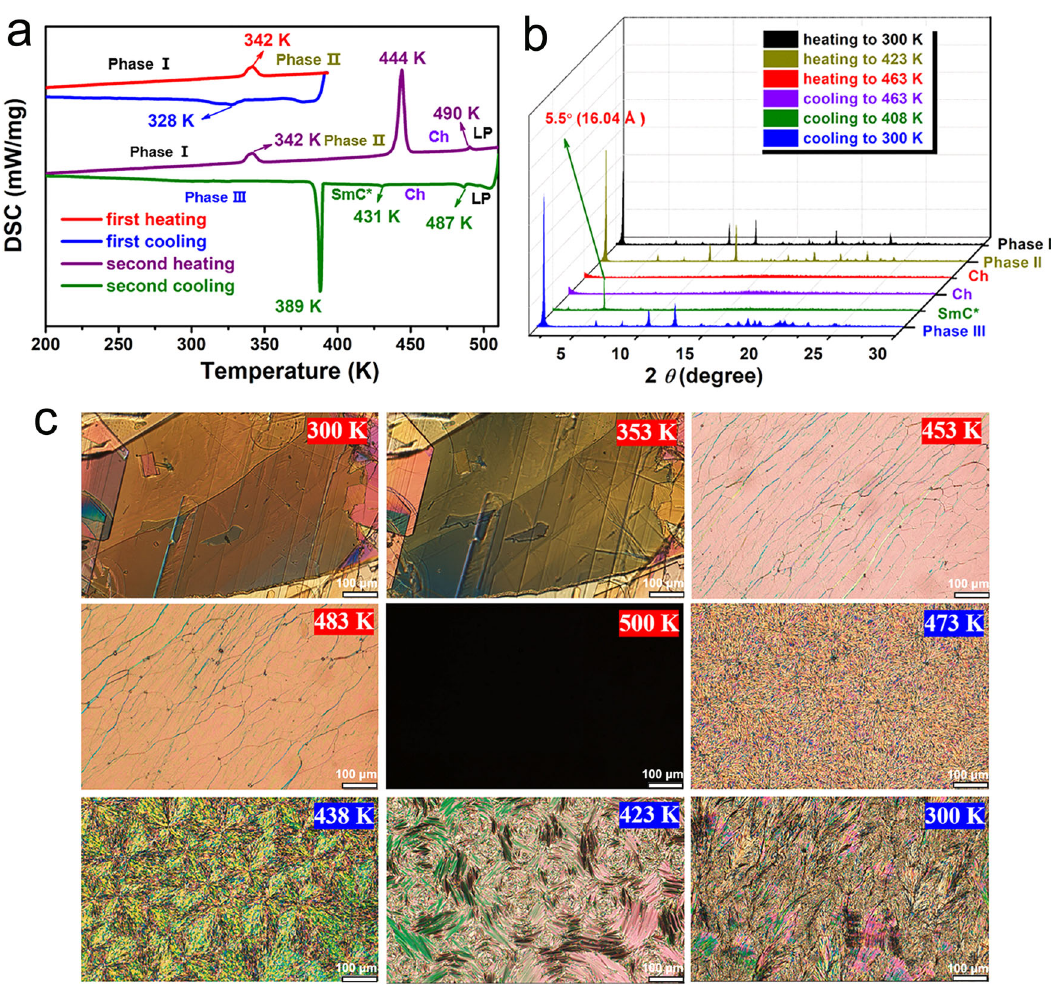
Fig. 3 | Phase transitions of 4I-CASS. a DSC curves of 4I-CASS. In the fi rst heating andcoolingruns,thephasebelow342KisphaseI,thephaseabove342Kbutbelow 444K is phase II, and the structural phase transition from phase I to phase II is completelyreversibleinthetemperaturerangebelowthetransitiontemperatureof 444K. In the second heating run, the phase between 444 and 490K is the choles- tericLCphase(Ch),and thephasebeyond 490Kisliquid phase(LP).Inthe second